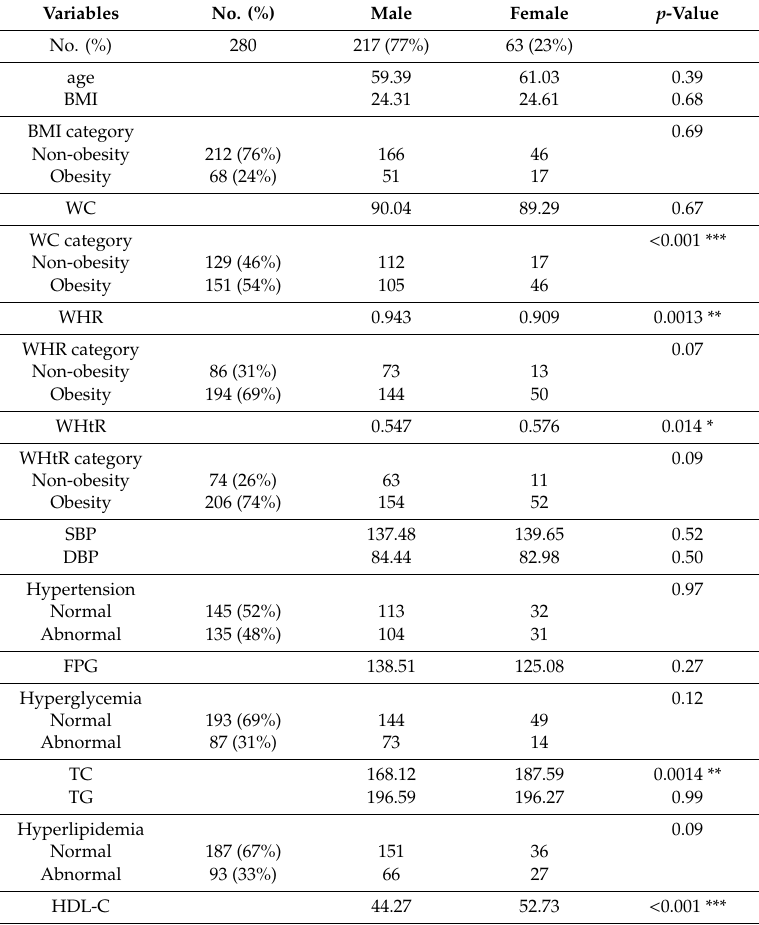
Table 2. Gender-based di ff erence